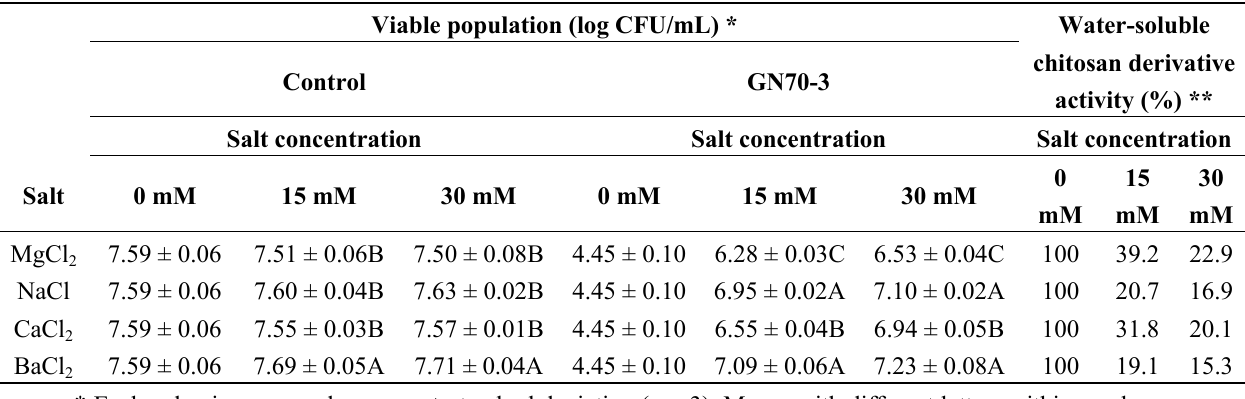
Table 2. Effect of salt addition on the antibacterial activity of chitosan derivative, GN70-3 (250 mg/L), against S. aureus in nutrient